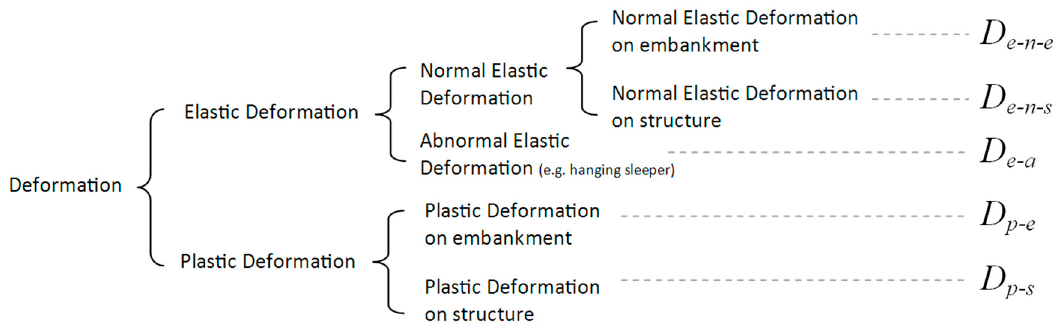
Figure 12. Deformation classification.